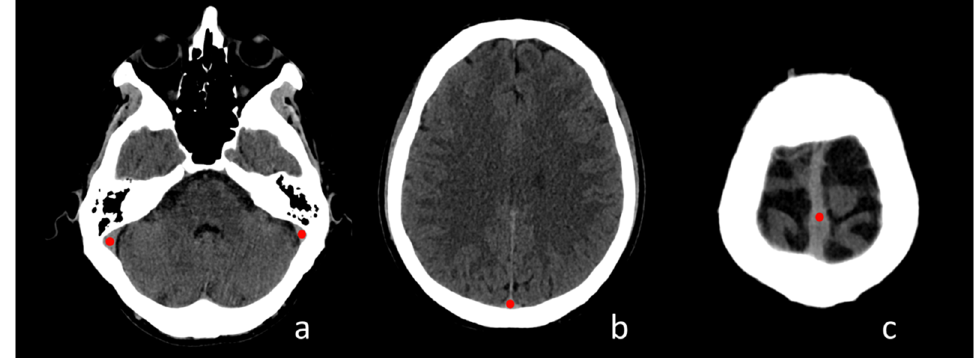
Figure 1. Regions of Interest placement in four standardized regions of the cerebral venous system; ( a ): transverse-sigmoid sinus passage; ( b ): posterior third of the superior sagittal sinus (SSS); ( c ): middle third of the SSS.